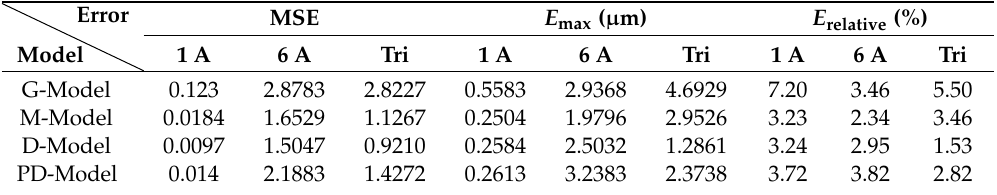
Table 2. MSE, E max and E relative of the displacement di ff erence between the predicted results of the ISSF-Duhem model and PD-Model with the identified parameters and the experimental tests when the magnetostrictive actuator is under 1 Hz harmonic input at di ff erent currents: 1 A and 6 A, and the triangle excitation current with various amplitudes. G-Model: the ISSF-Duhem model with Grompertz function-based shape function; M-Model: the ISSF-Duhem model with modified hyperbolic tangent function-based shape function; D-Model: the ISSF-Duhem model with a one-sided dead-zone operator-based shape function; PD-Model: the modified Prandtl–Ishlinskii model with a one-sided dead-zone operator. Tri: the triangle excitation current with various amplitudes.